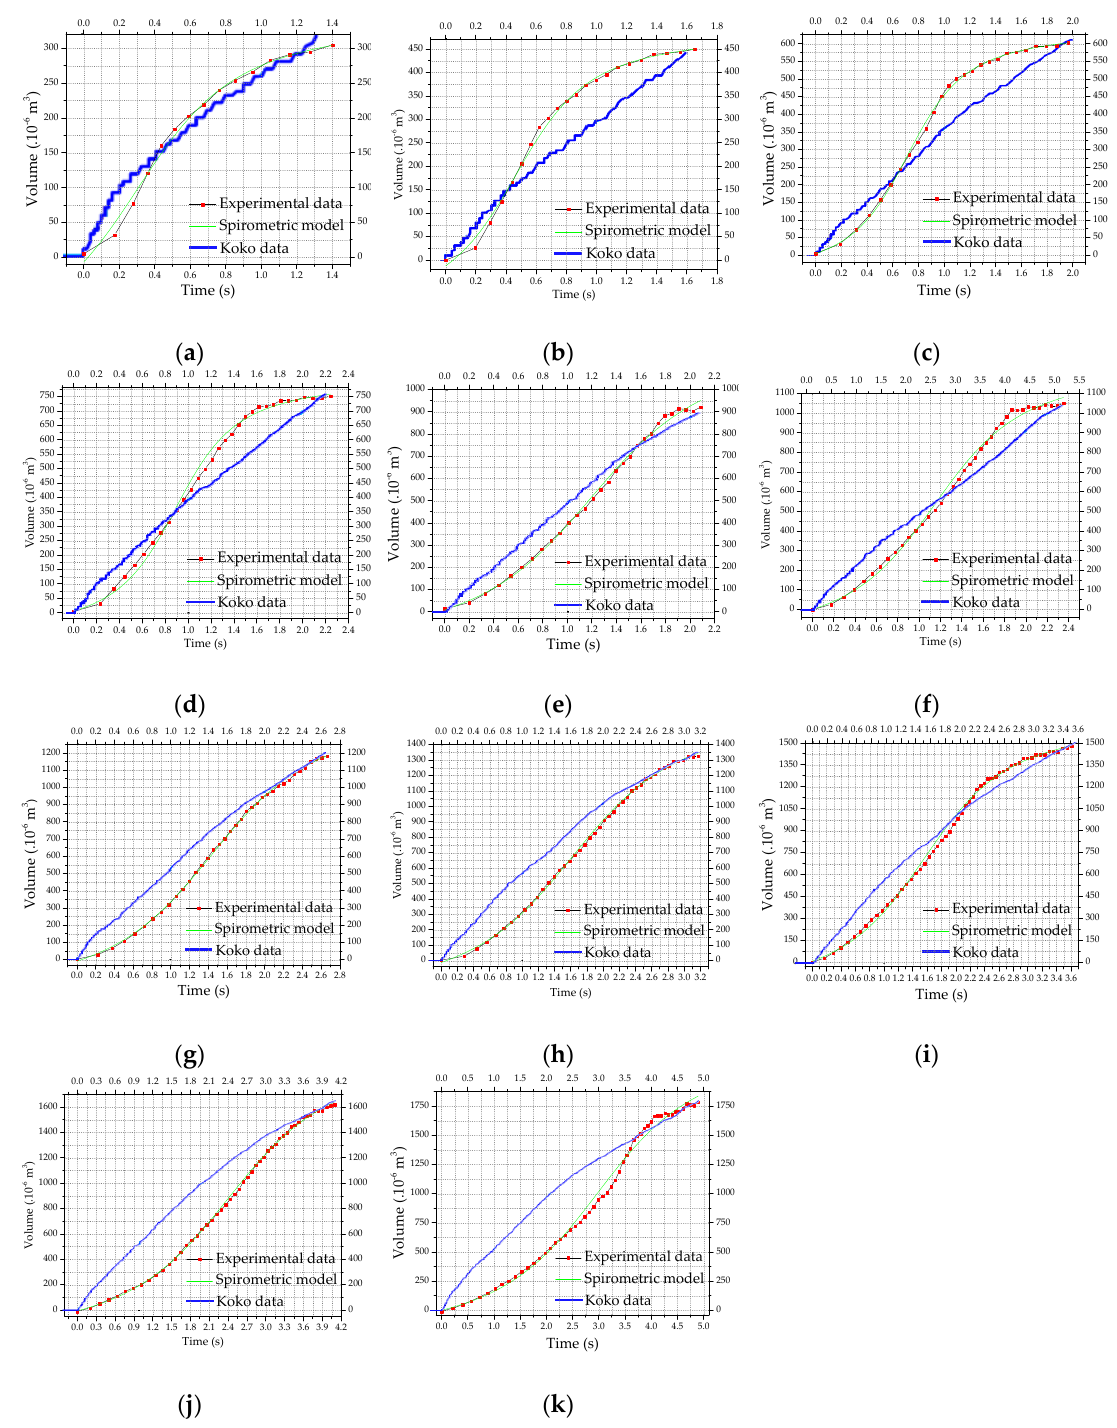
Figure 6. Result of validation of YF-S201 sensor with air: ( a ) 300 × 10 − 6 m 3 ; ( b ) 450 × 10 − 6 m 3 ; ( c ) 600 × 10 − 6 m 3 ; ( d ) 750 × 10 − 6 m 3 ; ( e ) 900 × 10 − 6 m 3 ; ( f ) 1050 × 10 − 6 m 3 ; ( g ) 1200 × 10 − 6 m 3 ; ( h ) 1350 × 10 − 6 m 3 ; ( i ) 1500 × 10 − 6 m 3 ; ( j ) 1650 × 10 − 6 m 3 and ( k ) 1800 × 10 − 6 m 3